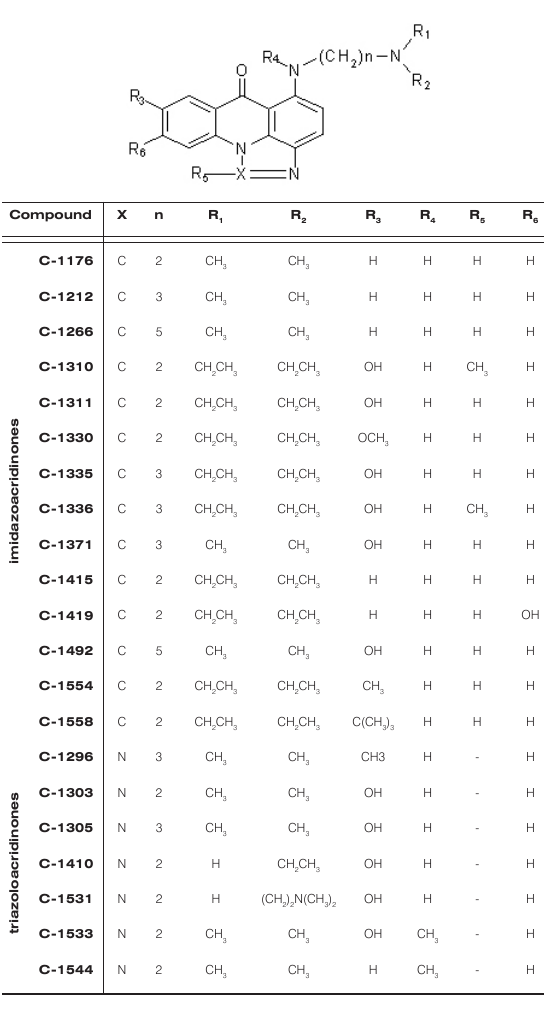
Figure 1. Chemical structure of studied